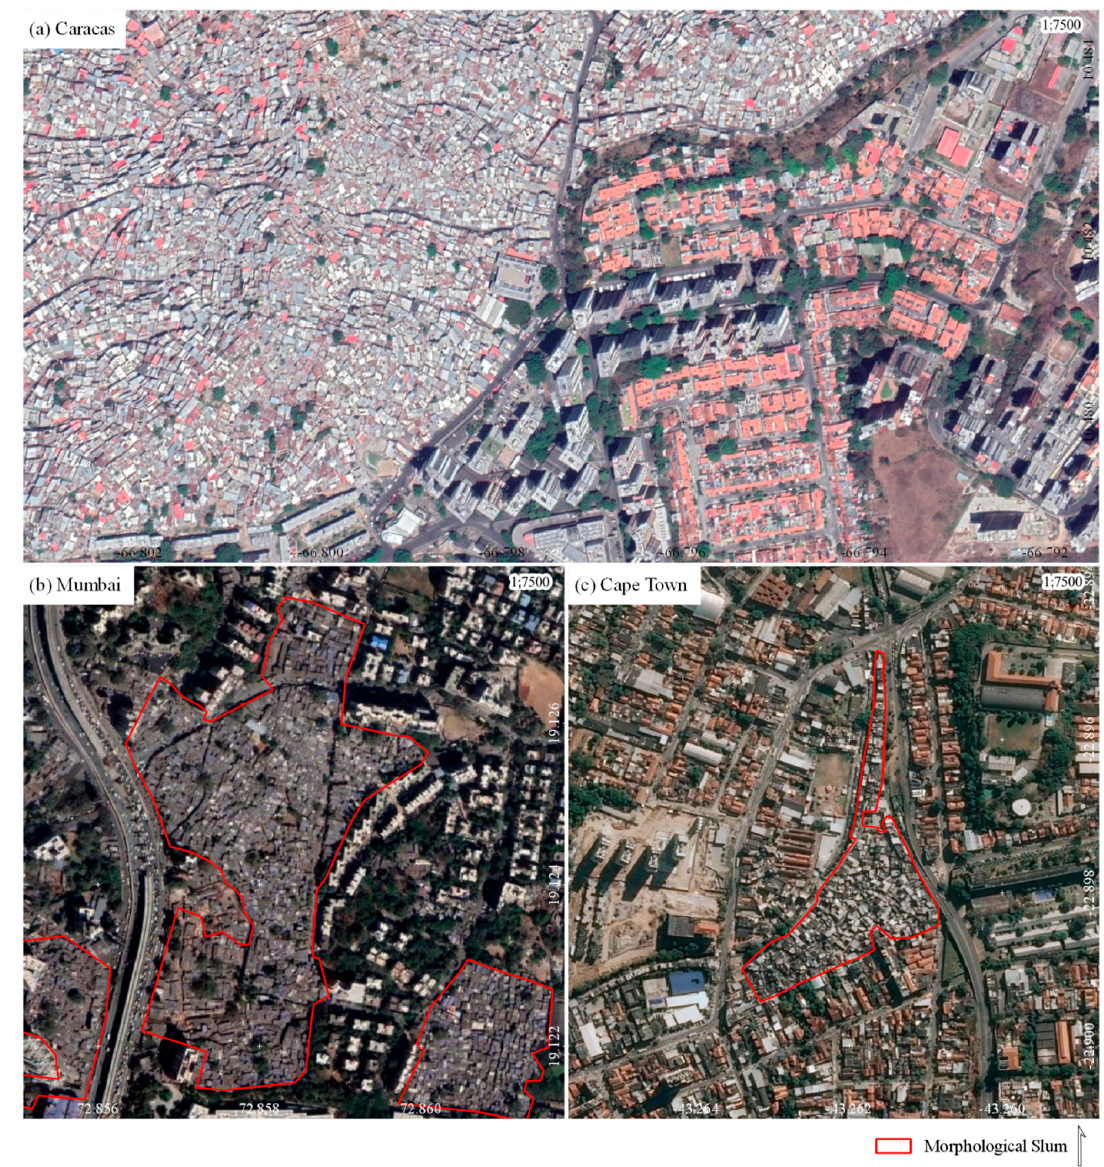
Figure 3. Slum demarcation based on morphological classification of very high-resolution (VHR) images in ( a ) Caracas, ( b ) Mumbai and ( c ) Cape Town.